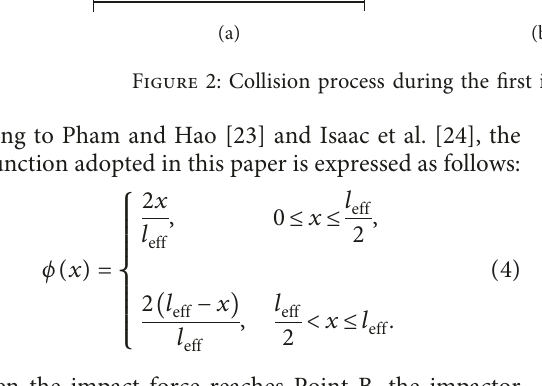
Figure 3: Winkler elastic foundation